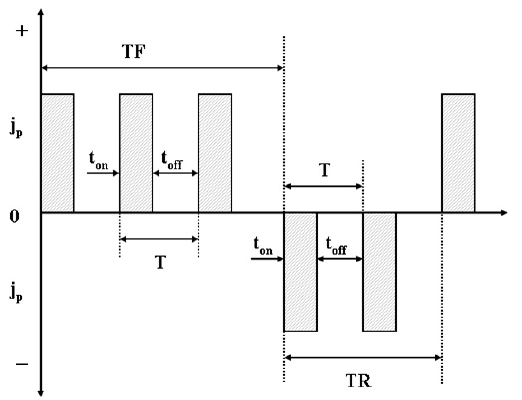
Figure 1. Schematic diagram of the experimental device. The copper electroplating bath solution was composed of 70 g/L CuSO 4 · 5H 2 O, 200 g/L sulfuric acid, 200 ppm polyethylene glycol (PEG, MW10000), 60 ppm Cl − and 10 mg/L thiazolinyl dithio propane sulfonate (SH110). The current density of the copper plating was controlled at 2 A/dm 2 (ASD) and the electroplating time was 2 h. Imposed pulse current included forward pulse current and reverse pulse current (Figure 2). The forward duty ratio is 0.4, the pulse frequency is 100 Hz, the forward working time is 100 ms, and the reverse working time is 20 ms. The reverse pulse current density, reverse pulse duty cycle, and frequency are summarized in the Table 1.